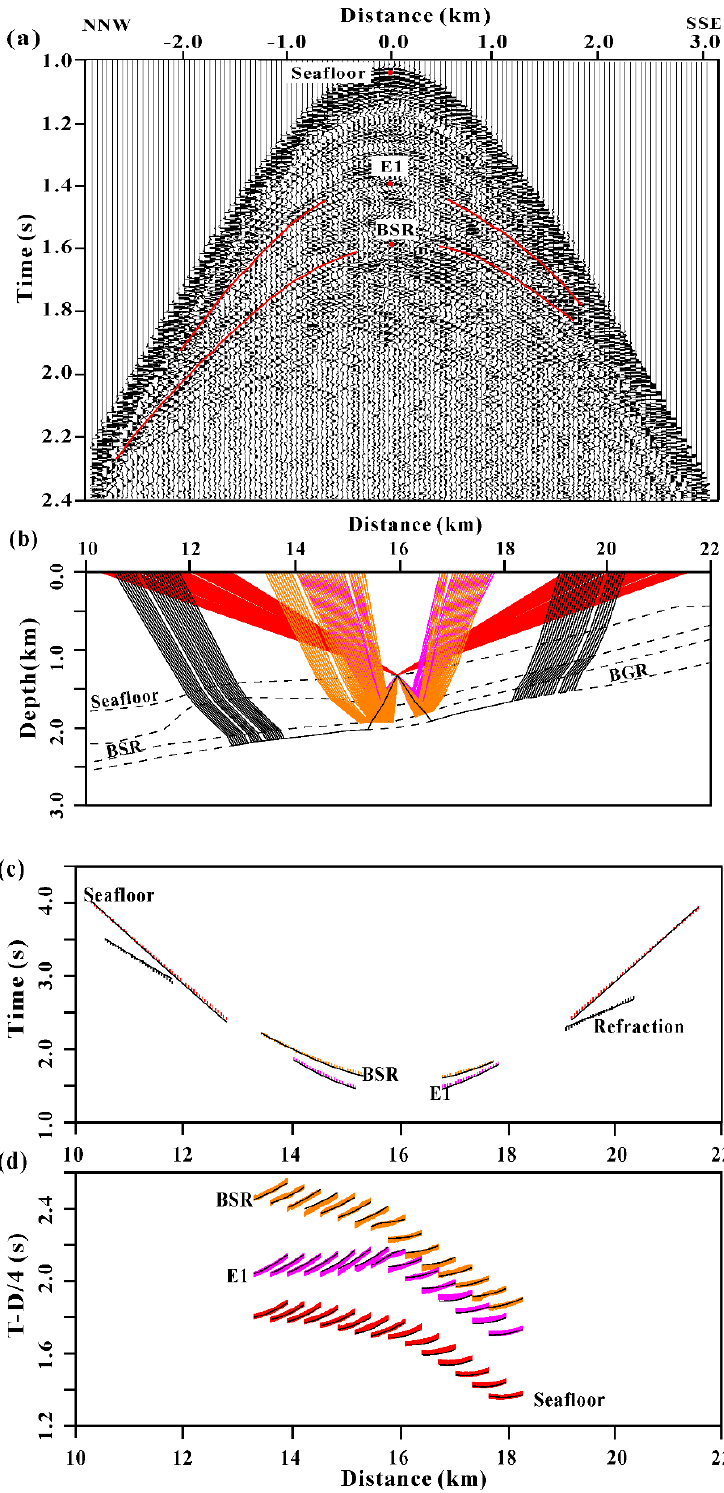
Figure 4. ( a ) Hydrophone component of OBS 7 showing travel time picks (red lines) of P-wave reflections used in the inversion. The horizontal axis is the distance between projected OBS position and shot position. The travel times at minimum offset corresponding to the reflections (Seafloor, E1, BSR) are indicated with the red dots; ( b ) P-wave ray diagram modeled on OBS 7. For clarity, rays modeled on MCS data are not shown; ( c ) the fit between calculated (solid lines) and observed (short vertical lines) travel times for OBS 7; ( d ) the fit between calculated (solid lines) and observed (short